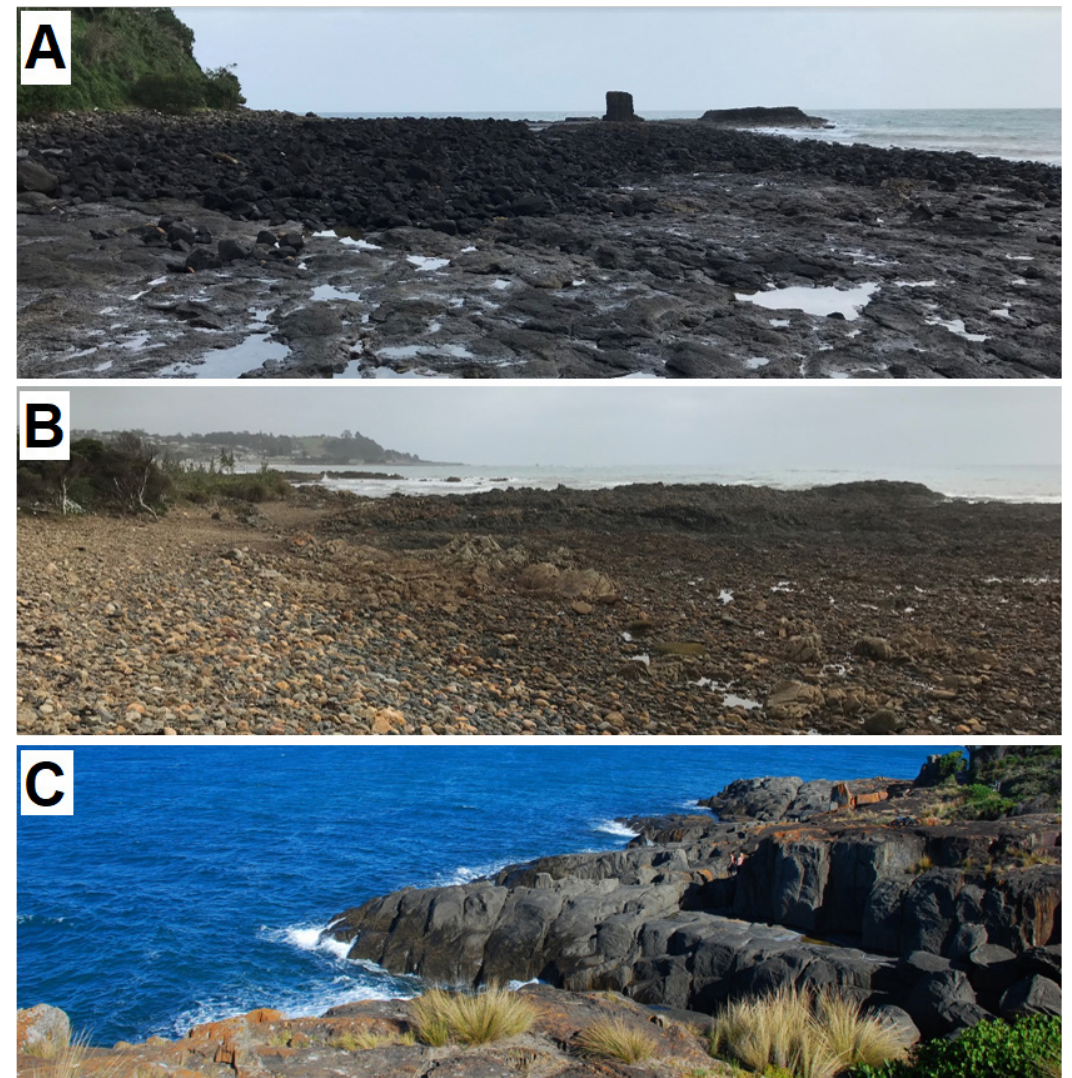
Figure 4. Imagery captured from each of the three coastal geoconservation sites during a site survey. A) Northwest facing view of Don Heads Basalt Landform geoconservation site (444000E, 5443389N). B) West-facing view of Pen- guin Megabreccia geoconservation site (423192E, 5447997N). C) East facing view of Mersey Bluff Pseudo-Petro- glyphs geoconservation site (446044E,